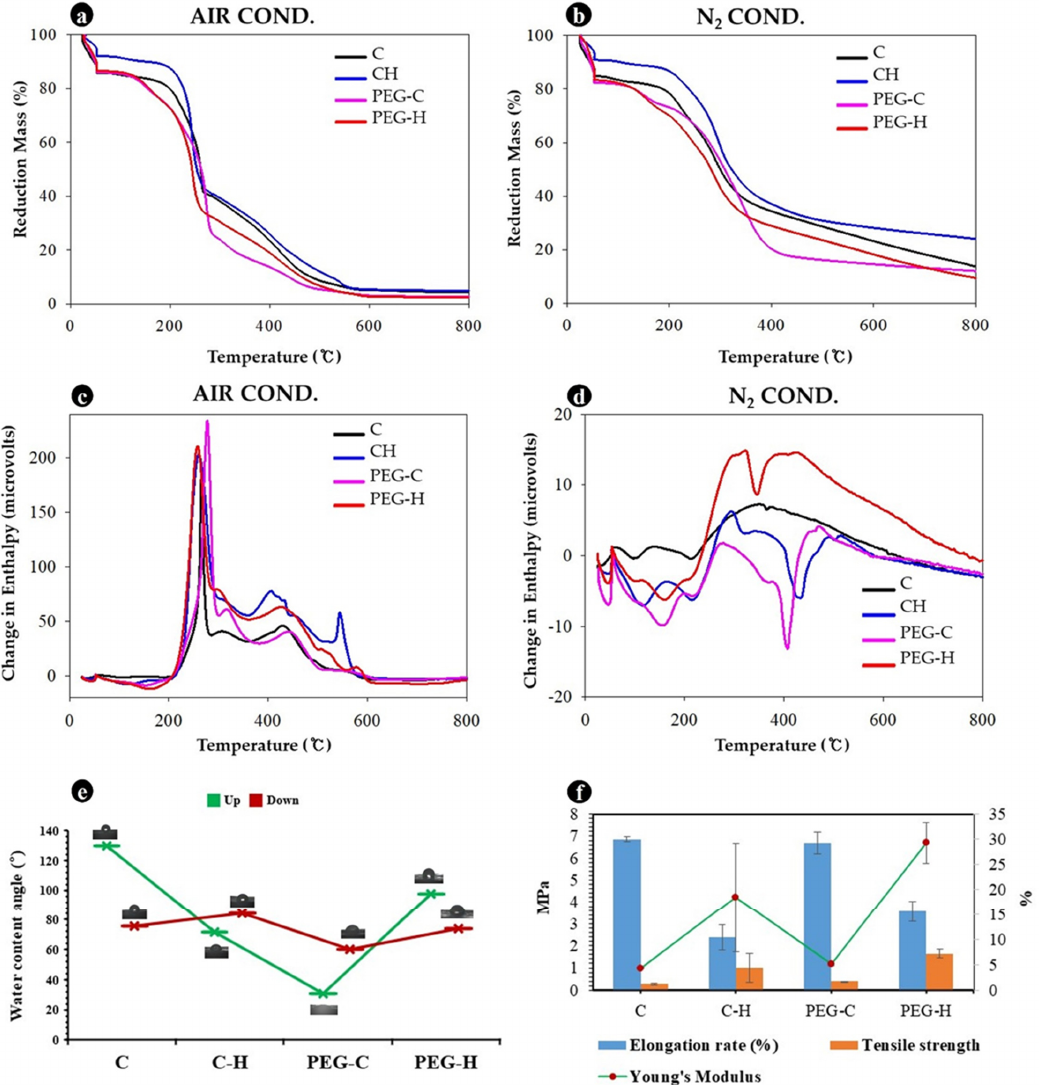
Figure 7. Chemical properties and mechanical properties of MBLs. ( a , b ) Thermal gravimetric analysis (TGA) assuming ( a ) air or ( b ) nitrogen atmosphere, with ( a ) slight weight increase observed (N 2 content reducing point increased, and the slight weight increase is in probably slow decomposition of the MBLs); ( c , d ) differential scanning calorimetry analysis (DTA); ( e ) water contact angle; ( f ) mechanical properties overview.